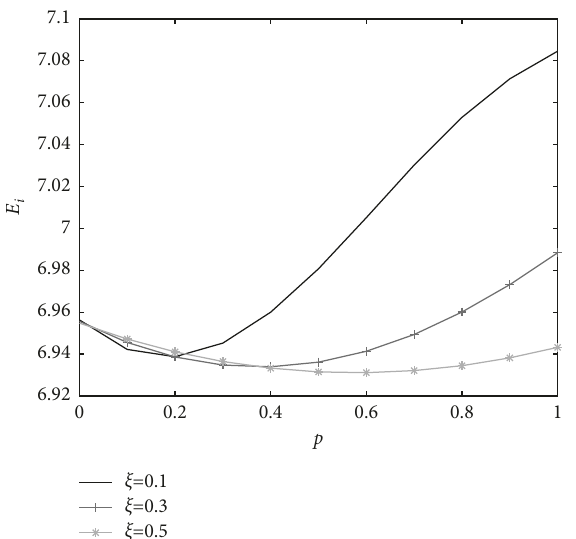
Figure 2: Effect of p on mean inventory level E patient rate ξ .